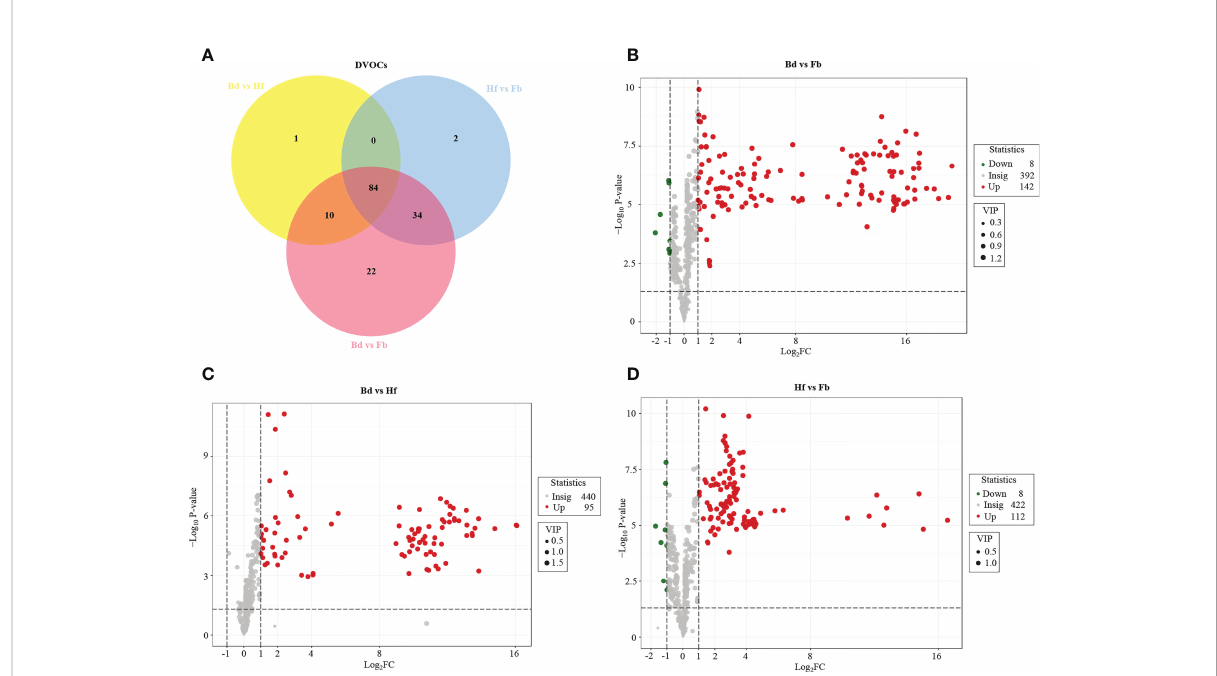
FIGURE 3 Differential volatile organic compounds (DVOCs) between different stages. (A) Venn diagram of DVOCs in D. Chrysotoxum fl owers. Volcano plots of DVOCs between different pairs of groups. Bd vs. Fb (B) , Bd vs. Hf (C) and Hf vs. Fb (D) . The green dots represent down-accumulated VOCs, and the red dots represent up-accumulated VOCs between different